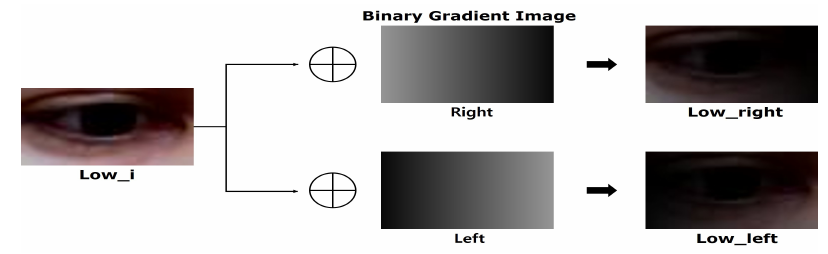
Figure 5. Generating process of directional light